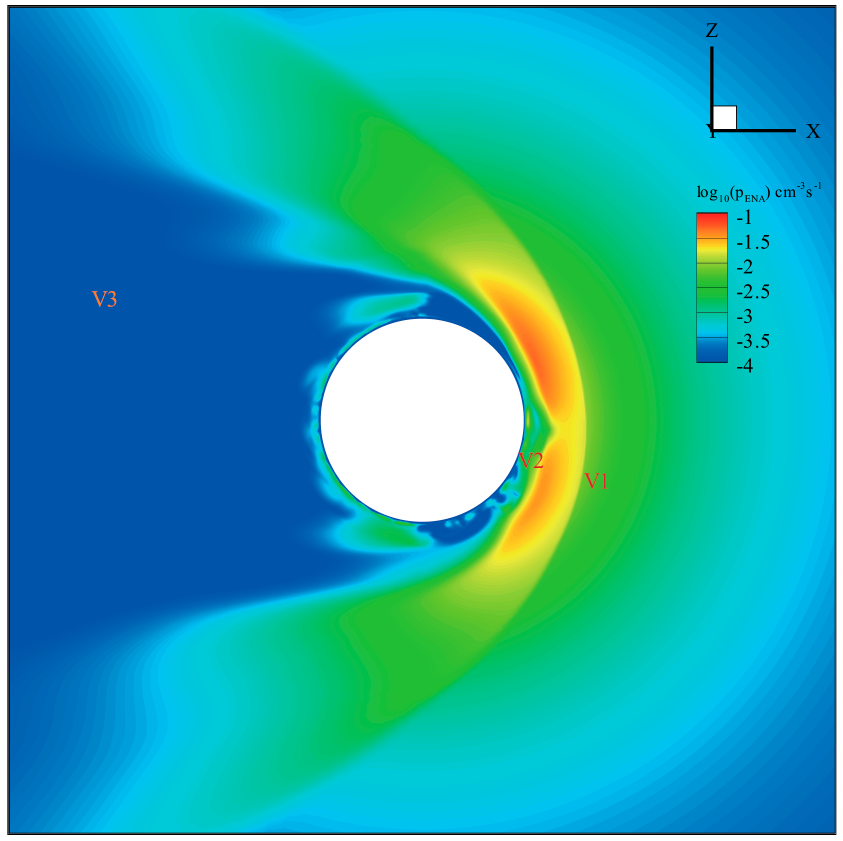
Figure 3. Global distribution of ENA production rate in the MSO X–Z plane. The color bar adapts to the logarithmic scale. Three virtual observation positions are labeled as V1, V2, and V3.